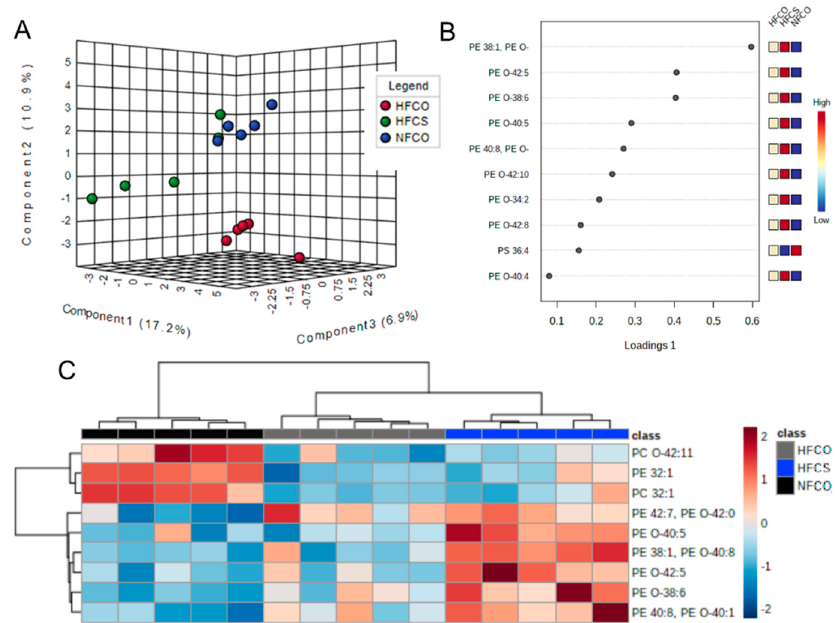
Figure 1. Phospholipid profile of Fetal (E17.5) livers in different maternal intake groups. ( A ) Sparse partial least squares discriminant analysis (sPLS-DA) scores plot. ( B ) Loadings plots of lipids that contributed to differences among groups. ( C ) Heatmap of phospholipids that differed among groups generated from Univariate ANOVA results with Euclidean distance measure and Ward clustering method (FDR-adjusted p < 0.05). CO, untreated control without choline supplement; CS, choline-supplemented; HF, high-fat; NF, normal-fat; PC, phosphatidylcholine; PE, phosphatidylethanolamine; O-, ether-linked fatty acid moiety. Table 1. Lipid species significantly differed between HFCS and the control groups. Lipid Species